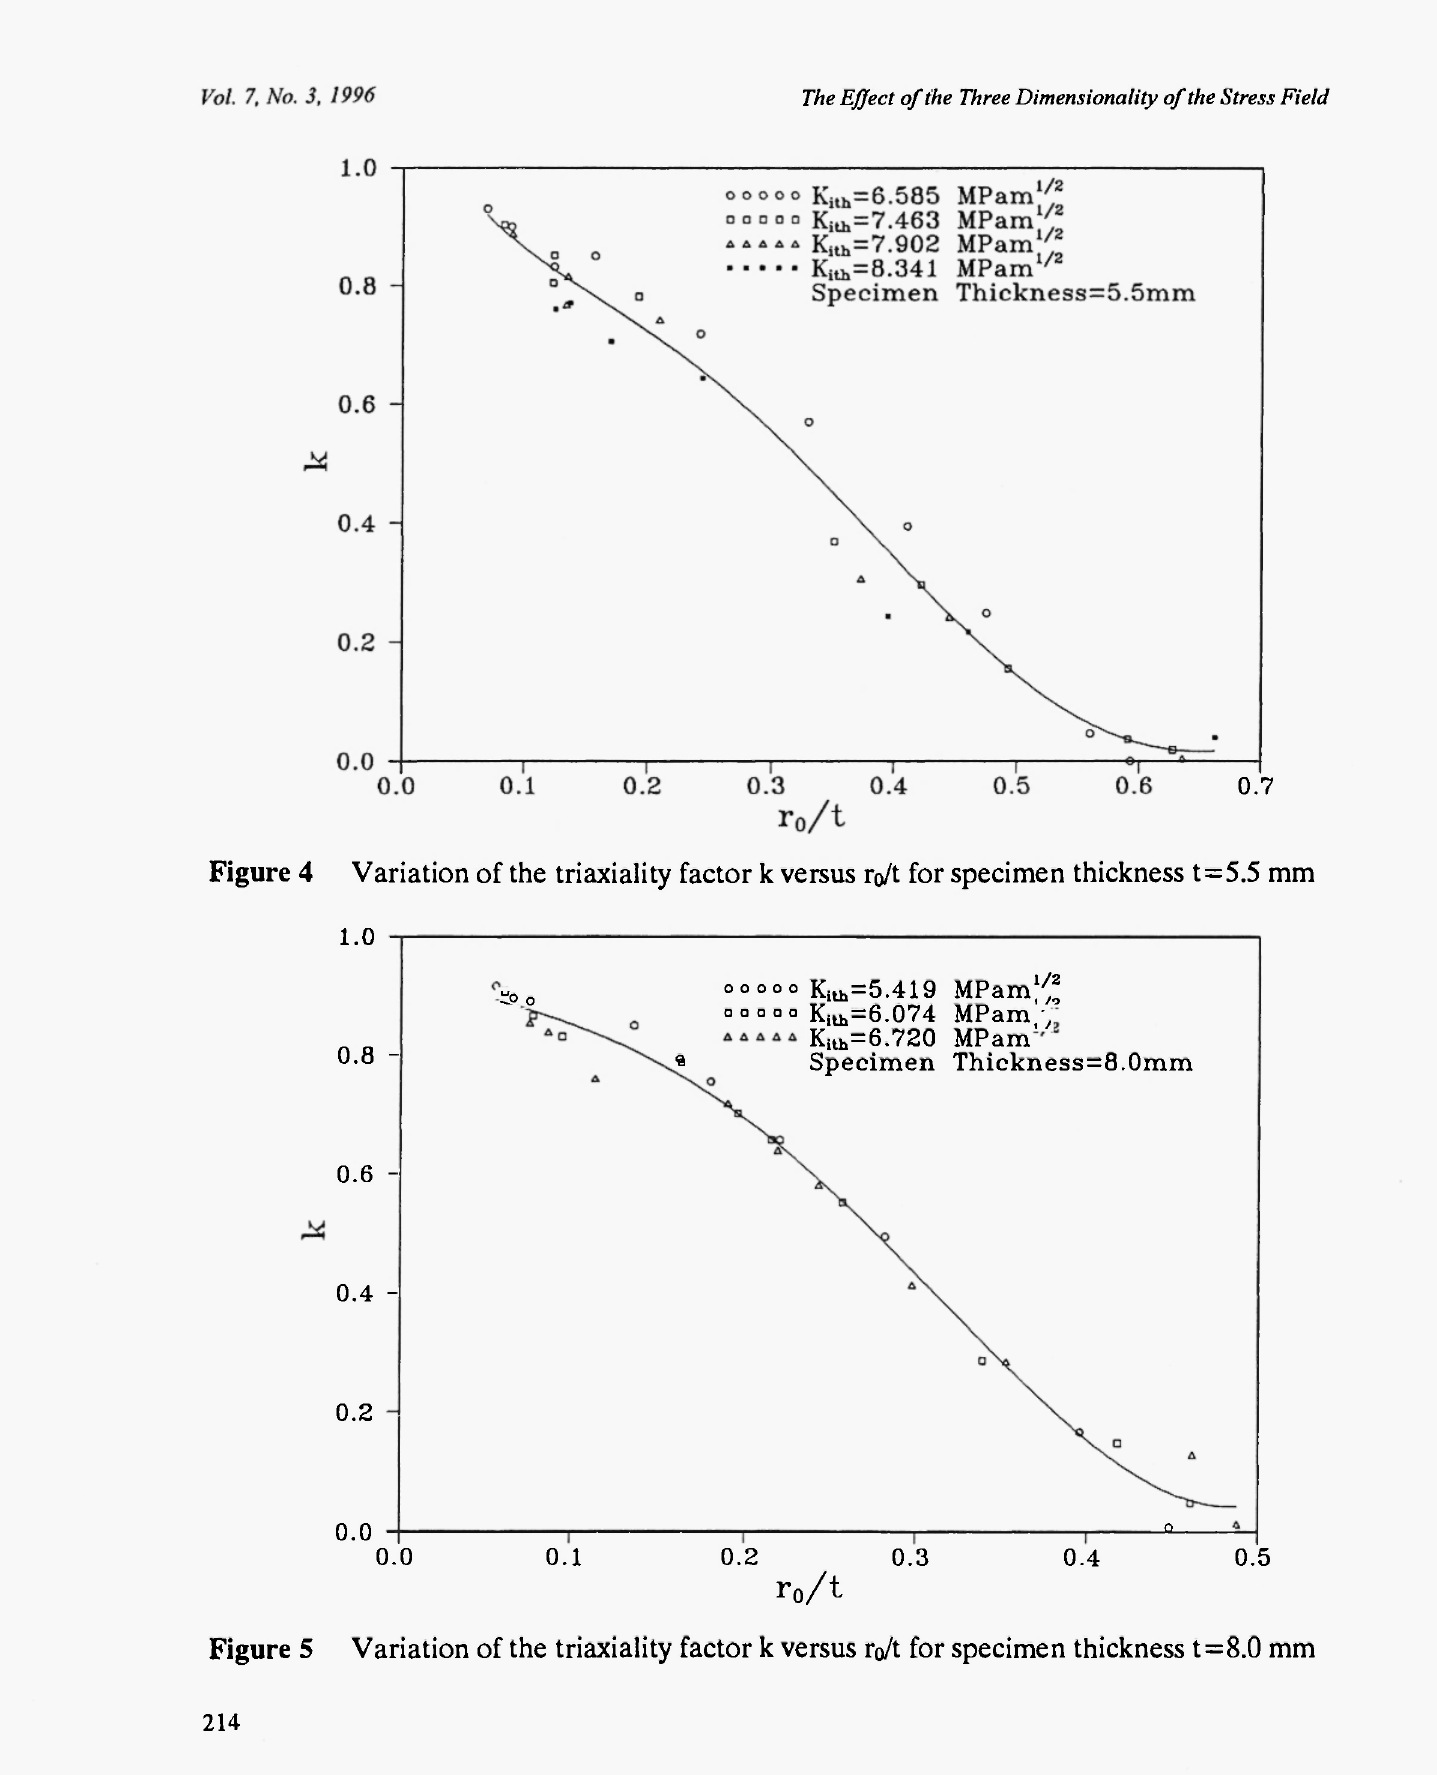
Figure 5 Variation of the triaxiality factor k versus ro/t for specimen thickness t=8.0 mm